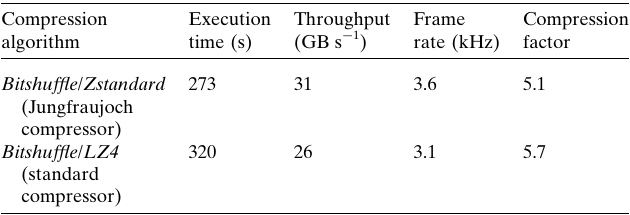
Table 1 Performance results for the Jungfraujoch FPGA and software show that the system has a significant margin over 2 kHz and potentially can reach a performance above 3 kHz. Presented numbers are from test handling one million images generated with the FPGA internal packet generator, corresponding in size to a 4M